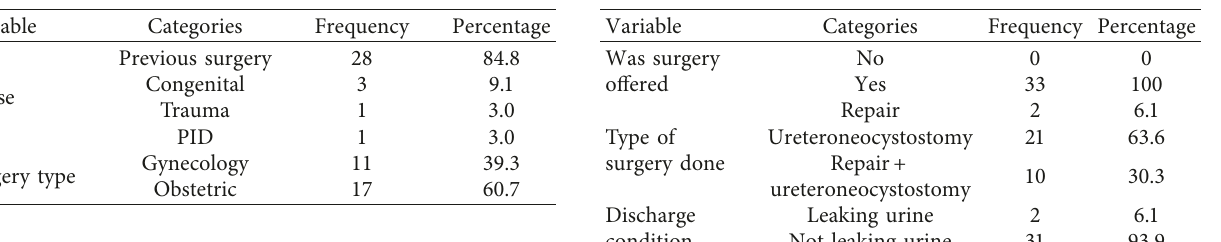
Table 3: Etiology of ureteric pathology.